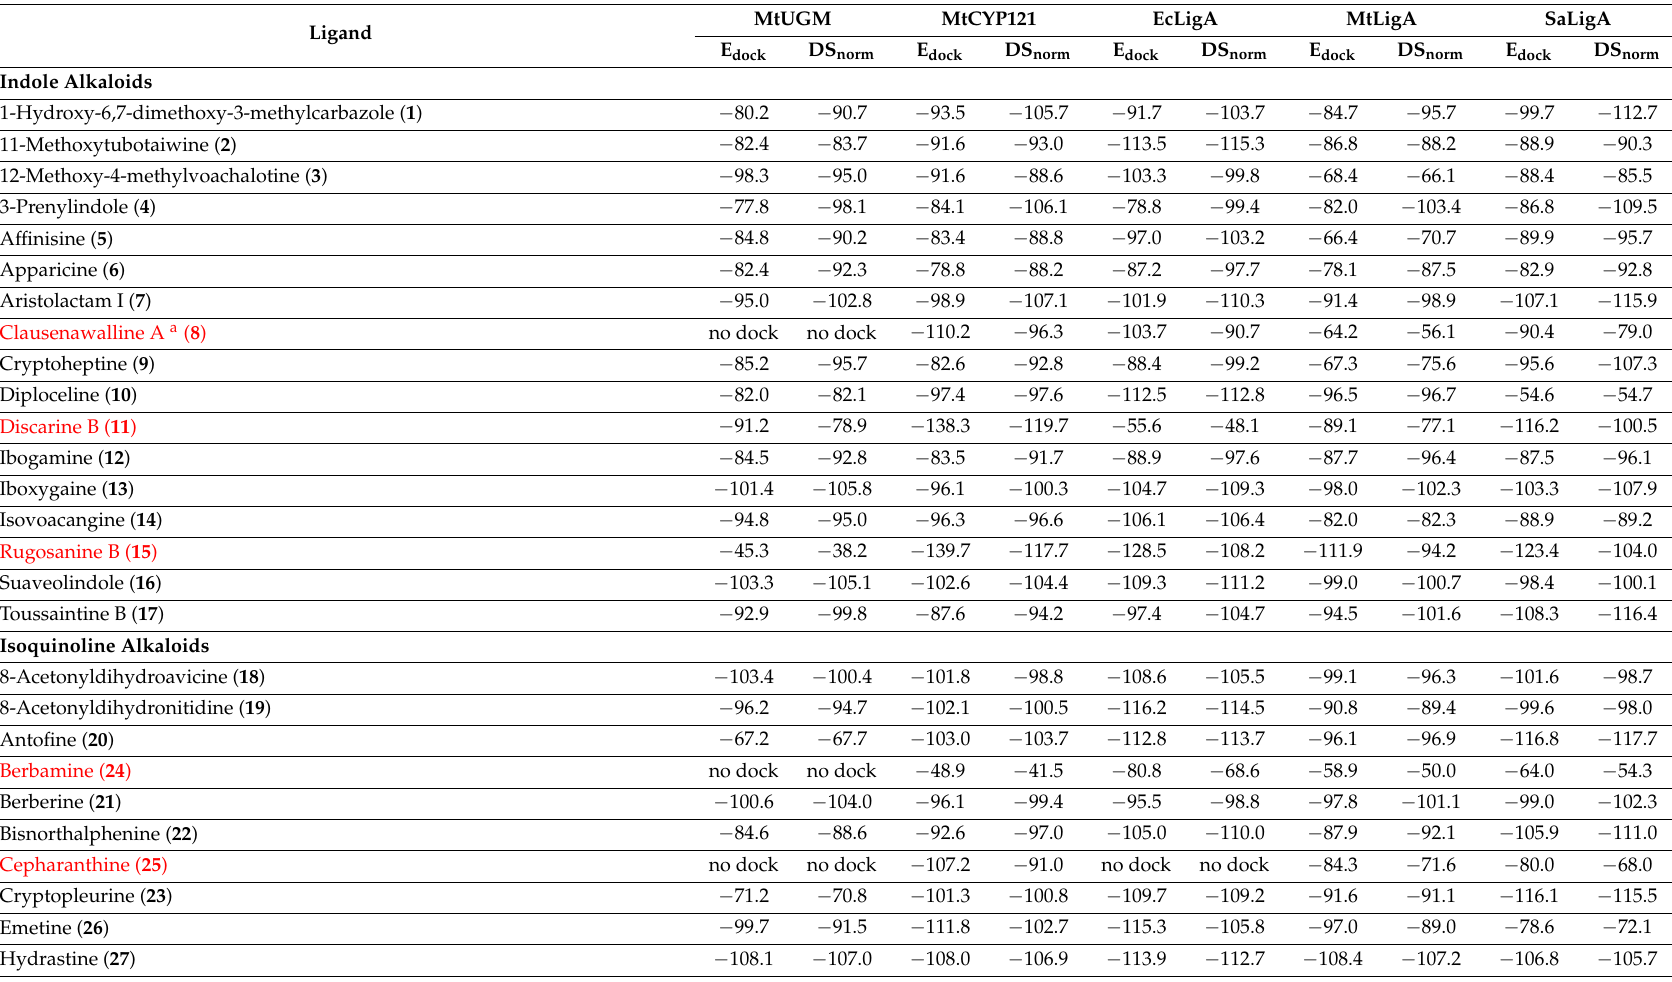
Table 4. MolDock molecular docking energies (E dock , kJ/mol) and normalized docking scores (DS norm ) for the antibacterial phytochemical ligands